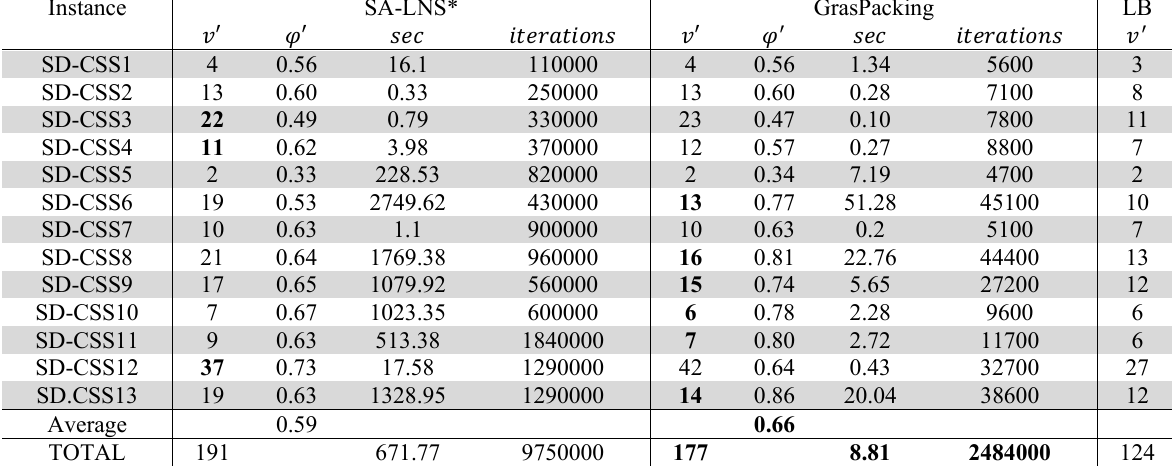
iterations. The Table 7 shows the comparison between the results provided by our metaheuristic and the best performance algorithm presented in Alvarez-Valdés et al. (2013), who uses a Pentium Mobile machine at 1500 MHz with 512Mbytes of post-processing after executing the Algorithm 4, achieving a better performance in the gaps obtained for each class (column